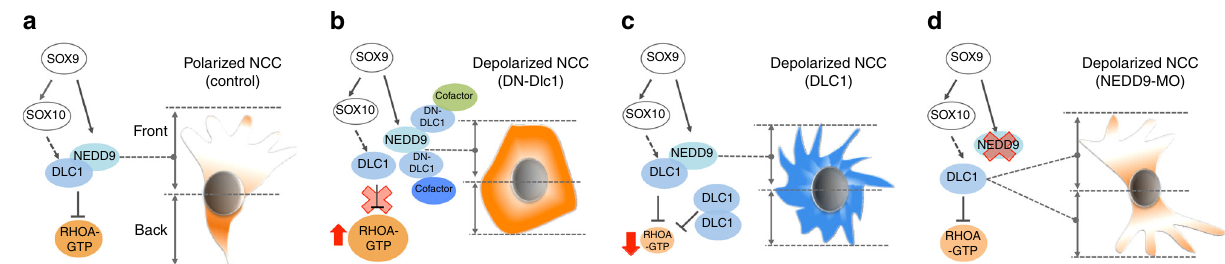
Fig. 8 Summary of the effects on RHOA activity and NC polarity following manipulation of DLC1 and NEDD9 functions. a SOX9 induces SOX10 to activate DLC1 expression (dotted arrows indicate transactivation is likely to be indirect), while SOX9 directly transactivates NEDD9 expression through binding to its enhancer regions. NEDD9 is required for the polarized expression of DLC1 and their interaction is crucial for the establishment of high RHOA activity at the back and low at the front that directs polarized NC morphology and motility. b Overexpression of DN-DLC1 disrupts the interaction between endogenous DLC1-NEDD9 and other cofactors through sequestration, resulting in elevation of RHOA activity throughout the cell and unpolarized NC morphology with defective motility. c Excessive amount of DLC1 inhibits RHOA activity throughout the cell, resulting in lack of polarized NC morphology and loss of directionality. d Expression of NEDD9-MO leads to lack of polarized DLC1 expression that in turn disrupts asymmetric distribution of active RHOA between the back and front of NCC which exhibits unpolarized morphology and limited factor for all the ratio calculation. The ratio values were normalized to the lower scale value (1.0). To avoid low intensity pixels, bottom 5% of the total histogram distribution was excluded. Finally, ratiometeric images were subjected to a Gaus- sian fi lter of width 2 pixels (0.32 μ m) to reduce pixel noise.